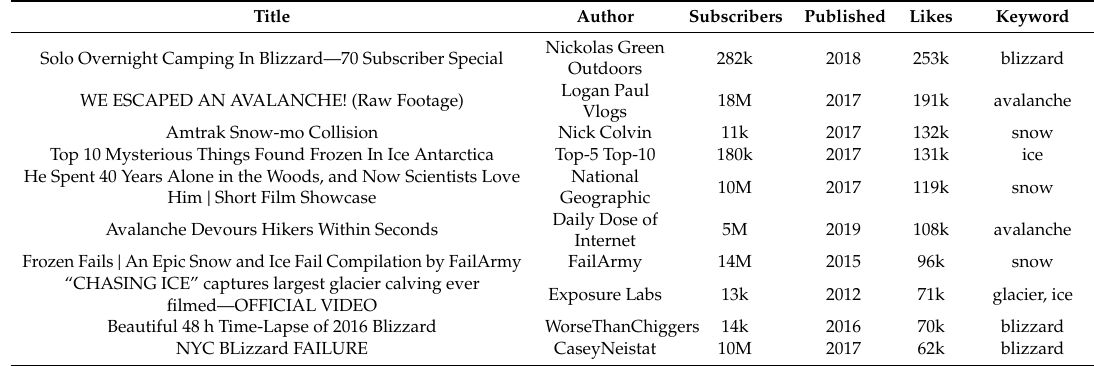
Table 3. The most liked videos with factual cryospheric content (in February2019).